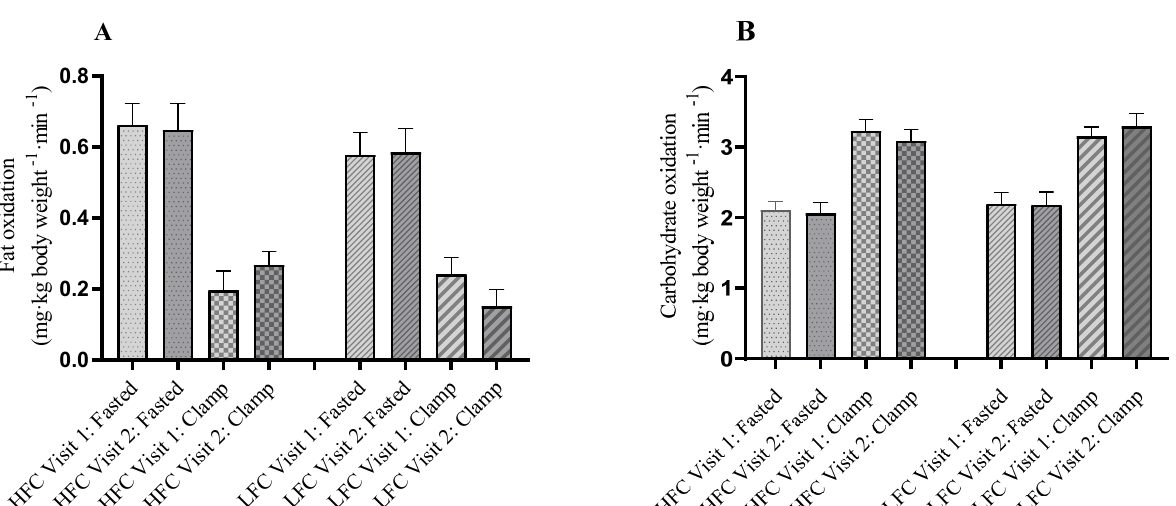
Figure 2. ( A ) Fat oxidation and ( B ) carbohydrate oxidation rates measured using indirect calorimetry before (Fasted) and at the end (150–165 min) of the hyperinsulinaemic clamp (‘Clamp’), PRE- and POST-intervention. Data for the high-flavanol cocoa (HFC; n = 14) and low-flavanol cocoa (LFC; n = 15) groups are the mean with SEM displayed as error bars.